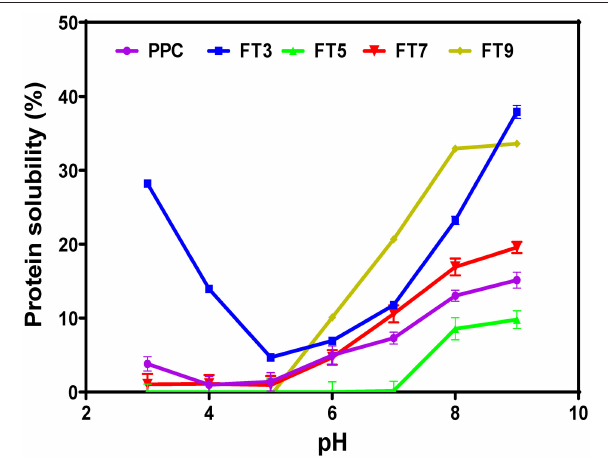
FIGURE 4 | pH solubility profile of pea protein concentrate (PPC) and > 50 kDa pea protein aggregates. PPC was heated at 100 ◦ C and varying pH, centrifuged and the supernatant passed consecutively through 30 and 50 kDa membranes. The final retentate from the 50 kDa membrane was collected as FT3, FT5, FT7, and FT9 for heat treatments at pH 3.0, 5.0, 7.0, and 9.0, respectively.